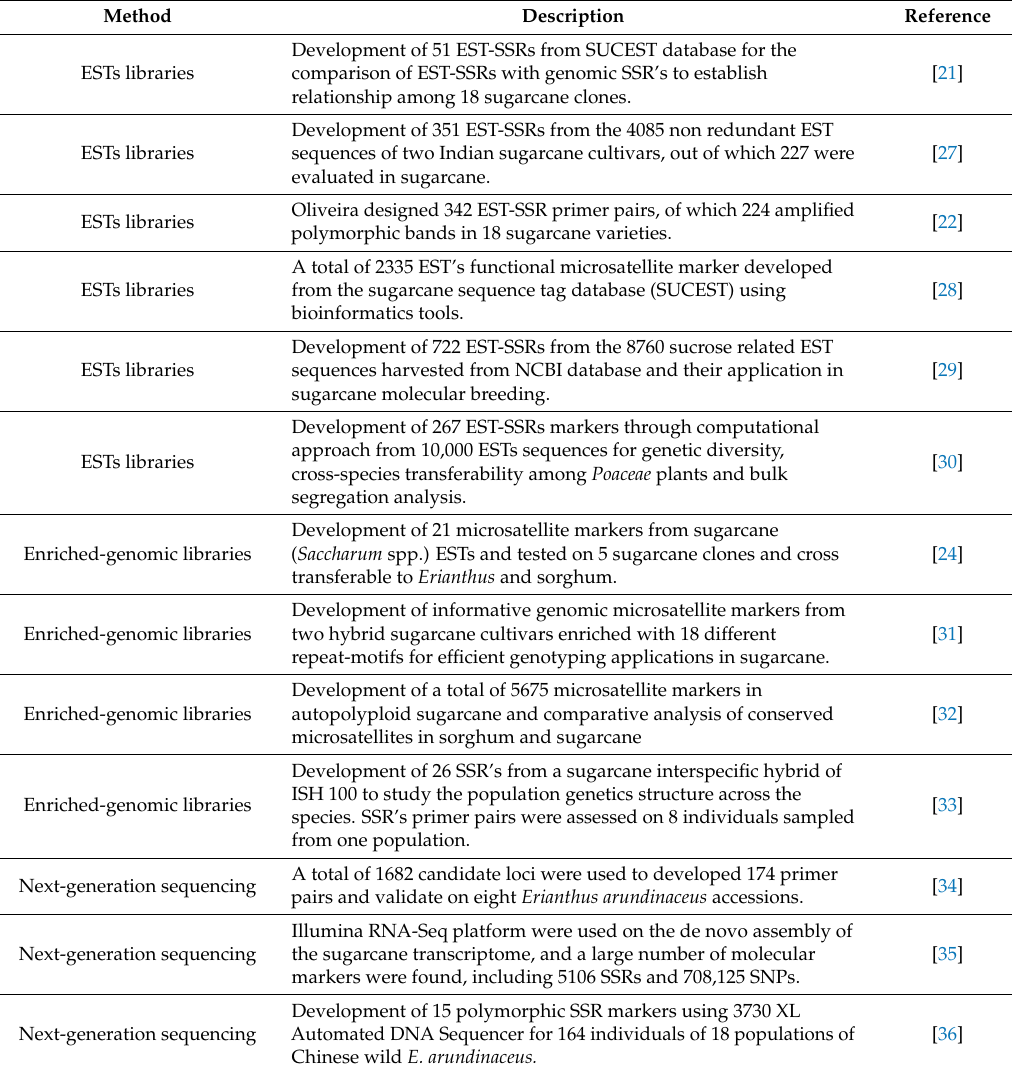
Table 2. Recent reports on the development of sugarcane SSRs through different